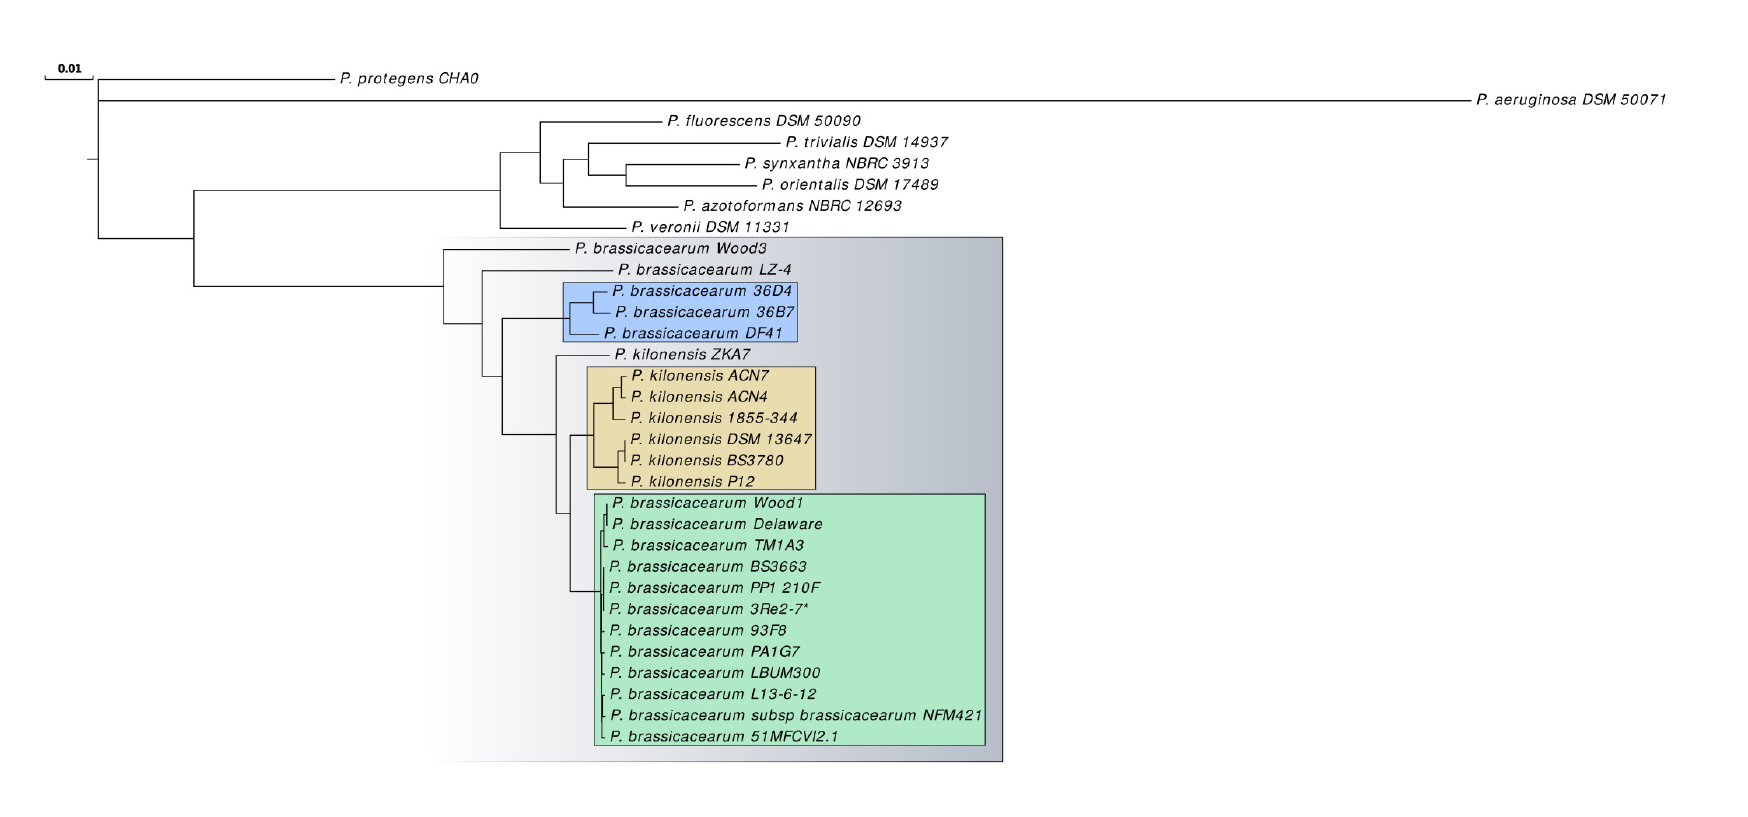
Figure 4. The phylogenetic relationship of P. brassicacearum species relative to other biocontrol Pseudomonas species. As outgroup, the type strain of the genus, P. aeruginosa DSM 50071 T , was included. The tree is based on 2331 core gene products. Selected clusters are indicated by colored boxes. Strain P. brassicacearum 3Re2-7 studied here is marked with an asterisk. The phylogenetic analysis was performed within the EDGAR 2.0 platform [42]. The bar indicates 1 substitutions per 100